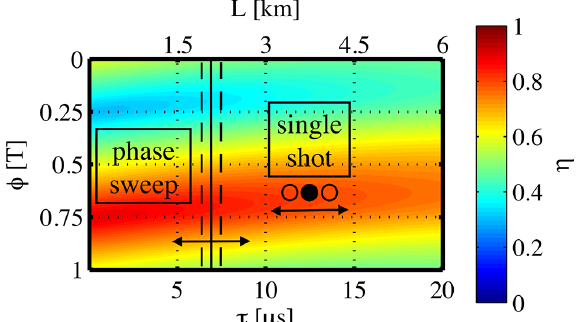
Figure 6. Illustration of the two ICOM operation modes. Phase sweep mode: the apparent transmission η (Eq. 4) is measured at a quasi-continuous set of phases. The acquired η Meas (φ) curve is then fitted into the modelled η Mod (φ,τ) landscape to retrieve the path length. Single-shot mode: the apparent transmission η is sampled at a fixed phase φ 0 . The acquired η(φ 0 ) is then fitted to a modelled η(φ 0 ,τ) curve to retrieve the path